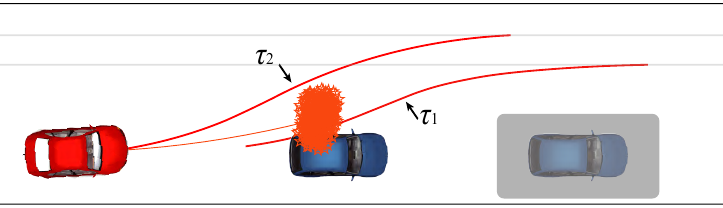
Figure 14. The generated particles and the driving envelope.